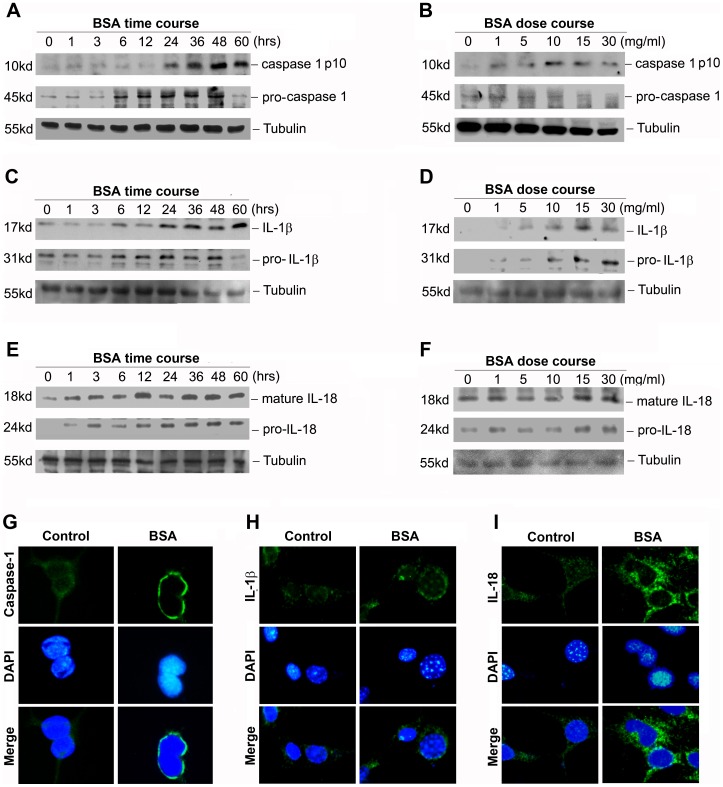
Bovine serum albumin induced the inflammasome activation in NRK-52E cells in vitro.A,C and E: Western blot analysis shows the caspase-1 activation and maturation of IL-1β and IL-18 protein in NRK-52E cells after treatment without or with 5 mg/ml BSA for various time periods in serum-free medium. The whole cell lysate was immunoblotted with caspase-1, IL-1β and IL-18 antibody, respectively. The same blot was reprobed with α-tubulin to confirm equal loading of each lane. B, D and F: Western blot analysis shows the caspase-1 activation and maturation of IL-1β and IL-18 protein in NRK-52E cells without or with different amounts of BSA for 12 h in serum-free medium. The whole cell lysate was also immunoblotted with caspase-1, IL-1β and IL-18 antibody, respectively. G through I: The inflammasome markers were detected by an indirect immunostaining in NRK-52E cells. NRK-52E cells were treated without (left column) or with 5 mg/ml BSA (right column) for 24 hours in serum-free medium. G: Immunostaining of caspase-1; H: Immunostaining of IL-1β; I: Immunostaining of IL-18.